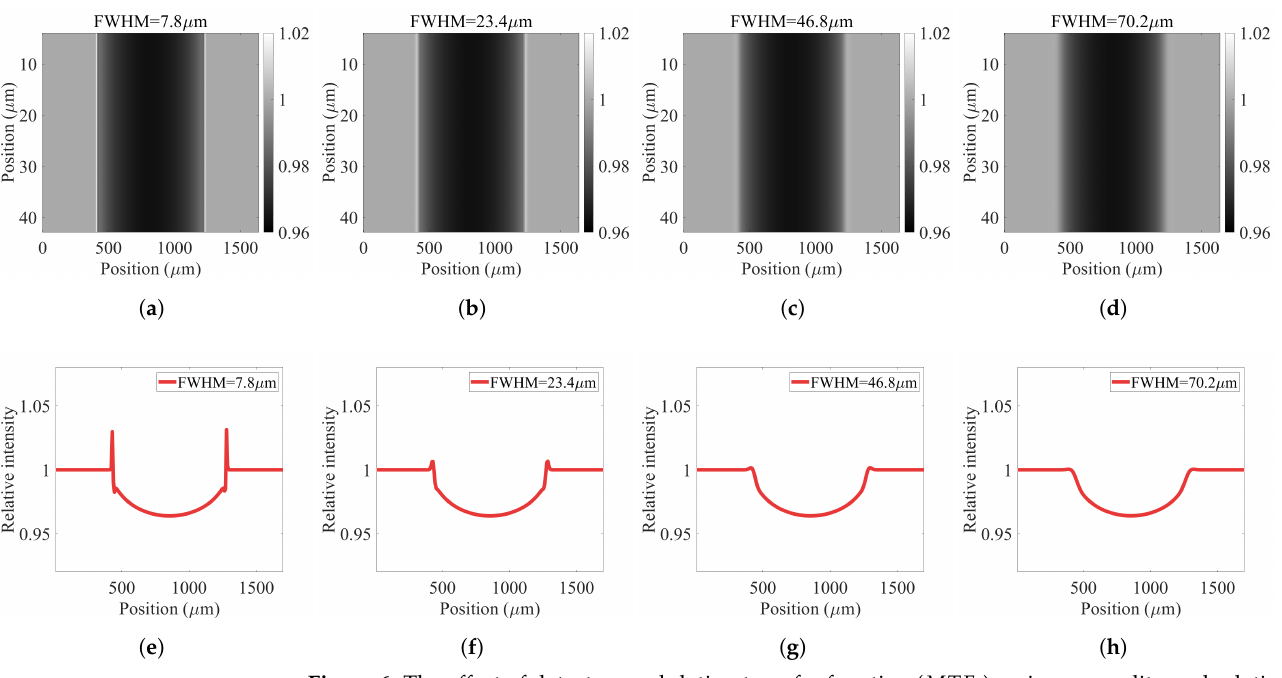
Figure 6. The effect of detector modulation transfer function ( MTF d ) on image quality and relative intensity. ( a , e ) represent a direct conversion detector with a pixel size equal to 7.8 µ m. ( b , f ) represent a direct conversion detector with a pixel size equal to 23.4 µ m. ( c , g ) represent a direct conversion detector with a pixel size equal to 46.8 µ m. ( d , h ) represent a direct conversion detector with a pixel size equal to 70.2 µ m. Simulation is done for a PEEK wire with 585 µ m in diameter using a polychromatic microfocus X-ray source working at 60 kV p with a spot size equal to 2 µ m to only study and highlight the effect of MTF d on the system